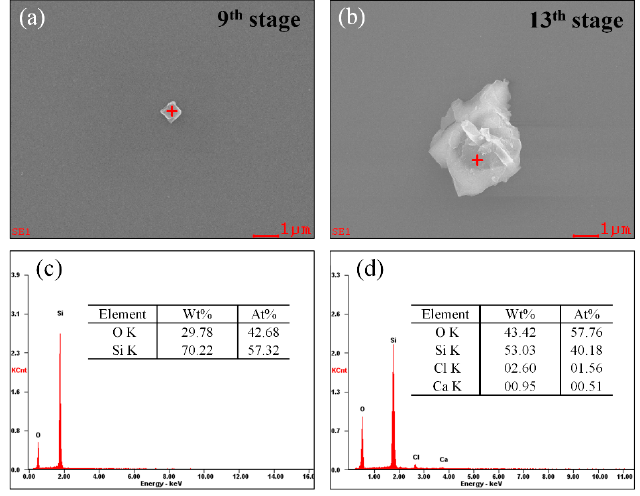
Figure 7. SEM–EDS analysis results of particles collected on the Si wafer substrate with ELPI. ( a , c ) Particles from the 9th stage; ( b , d ) particles from the 13th